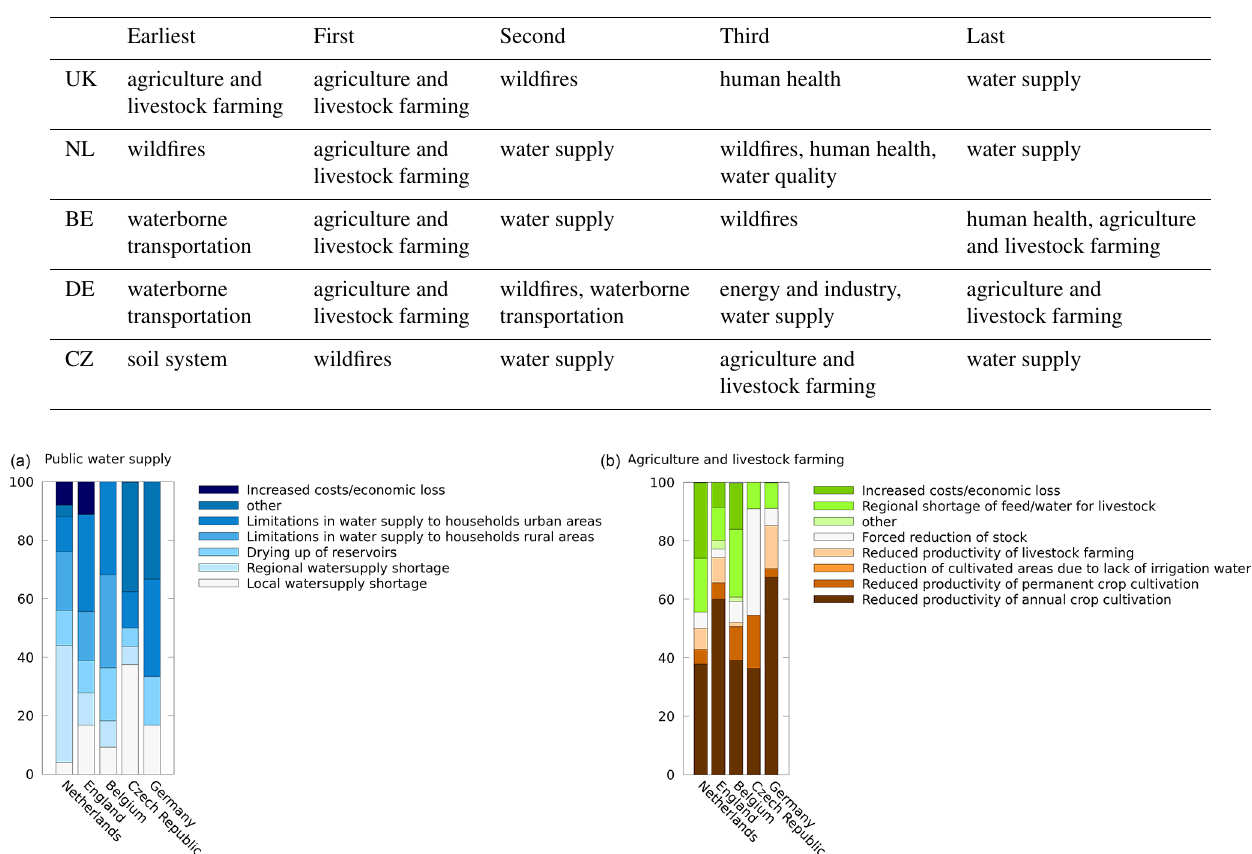
Table 1. Earliest and latest reported impacts for the five countries, and the top three of the most reported impacts for 1921.